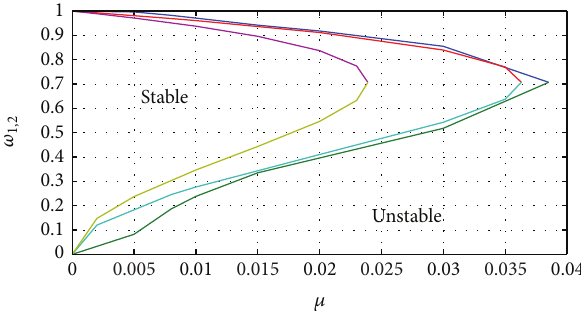
Figure 18: Combined graph for binary systems Luyten-I, II, and III.